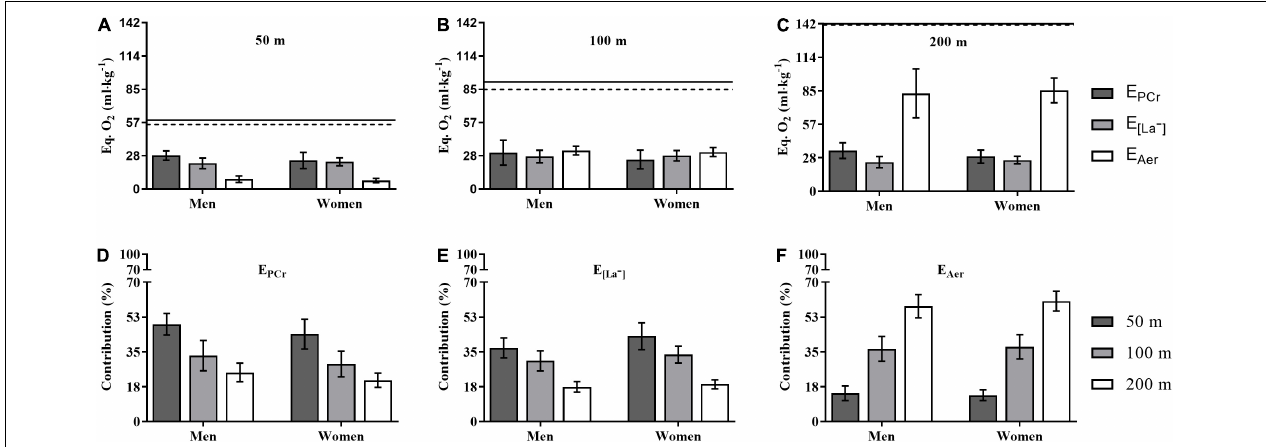
FIGURE 3 | The energetic demand (A–C) contribution (D–F) to the performance in 50, 100, and 200 m for men and women. Obs.: Horizontal continuous and traced lines at the top of Panels (A–C) refer to E Total for men and women, respectively. The acronyms E PCr , E [ La − ] , and E Aer represent the phosphagenic, glycolytic, and aerobic components of E Total . See text for statistical